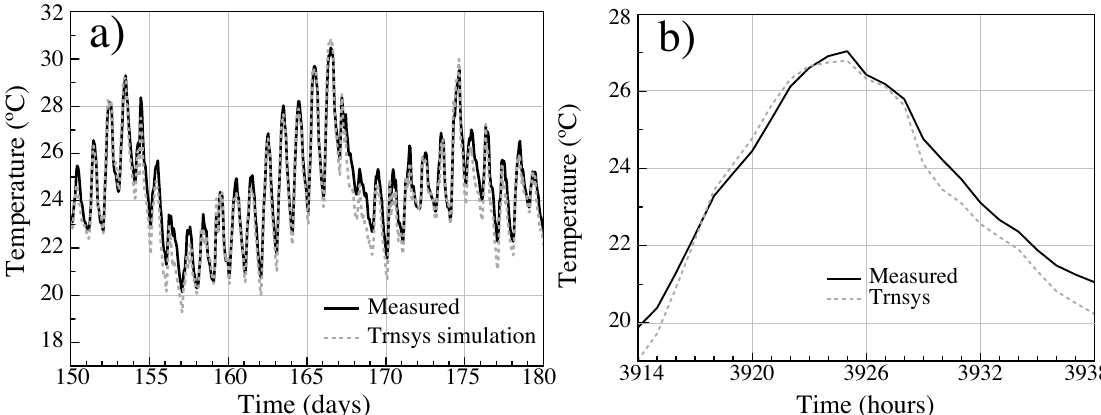
Figure 8. Comparison between the real data obtained by Equs and theoretical simulations results of the first case of study for the month of June ( a ) and a single day of June ( b ).